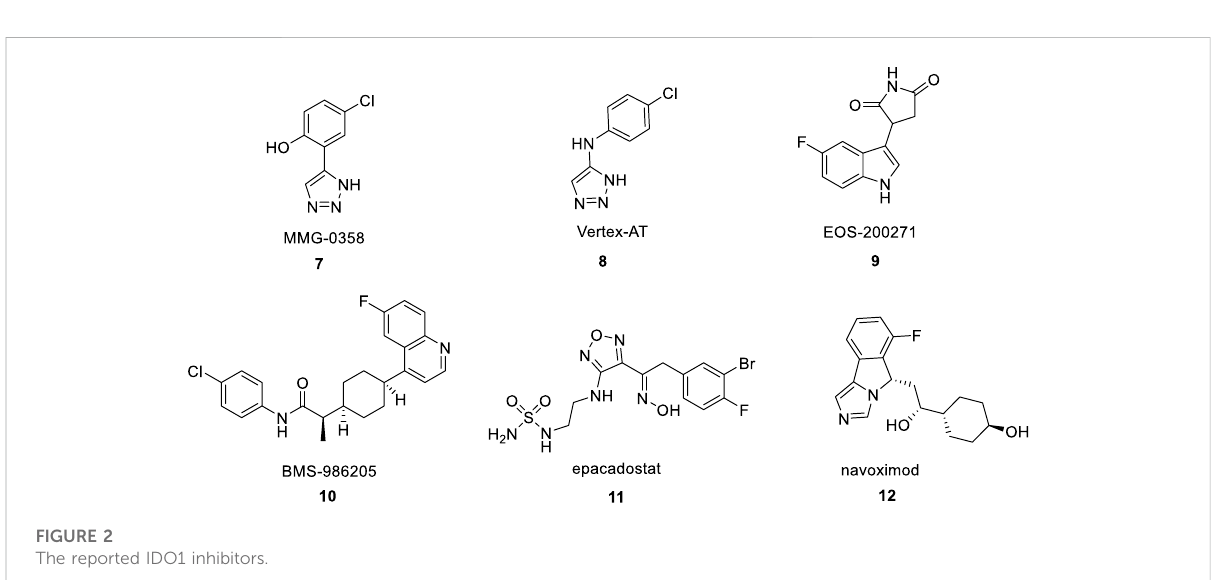
FIGURE 2 The reported IDO1